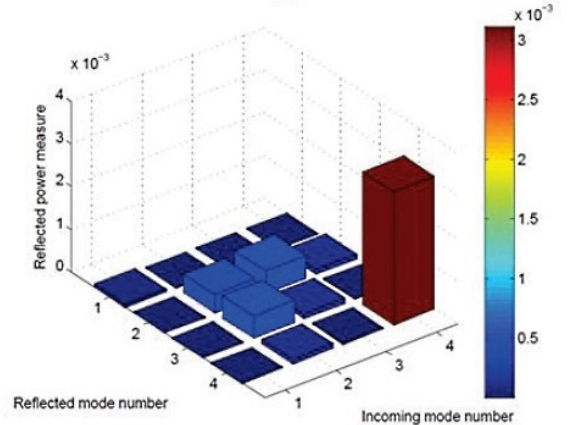
Figure A2. Reflection map for a thermite weld with a 6 mm thick weld cap (picture taken from Ref.